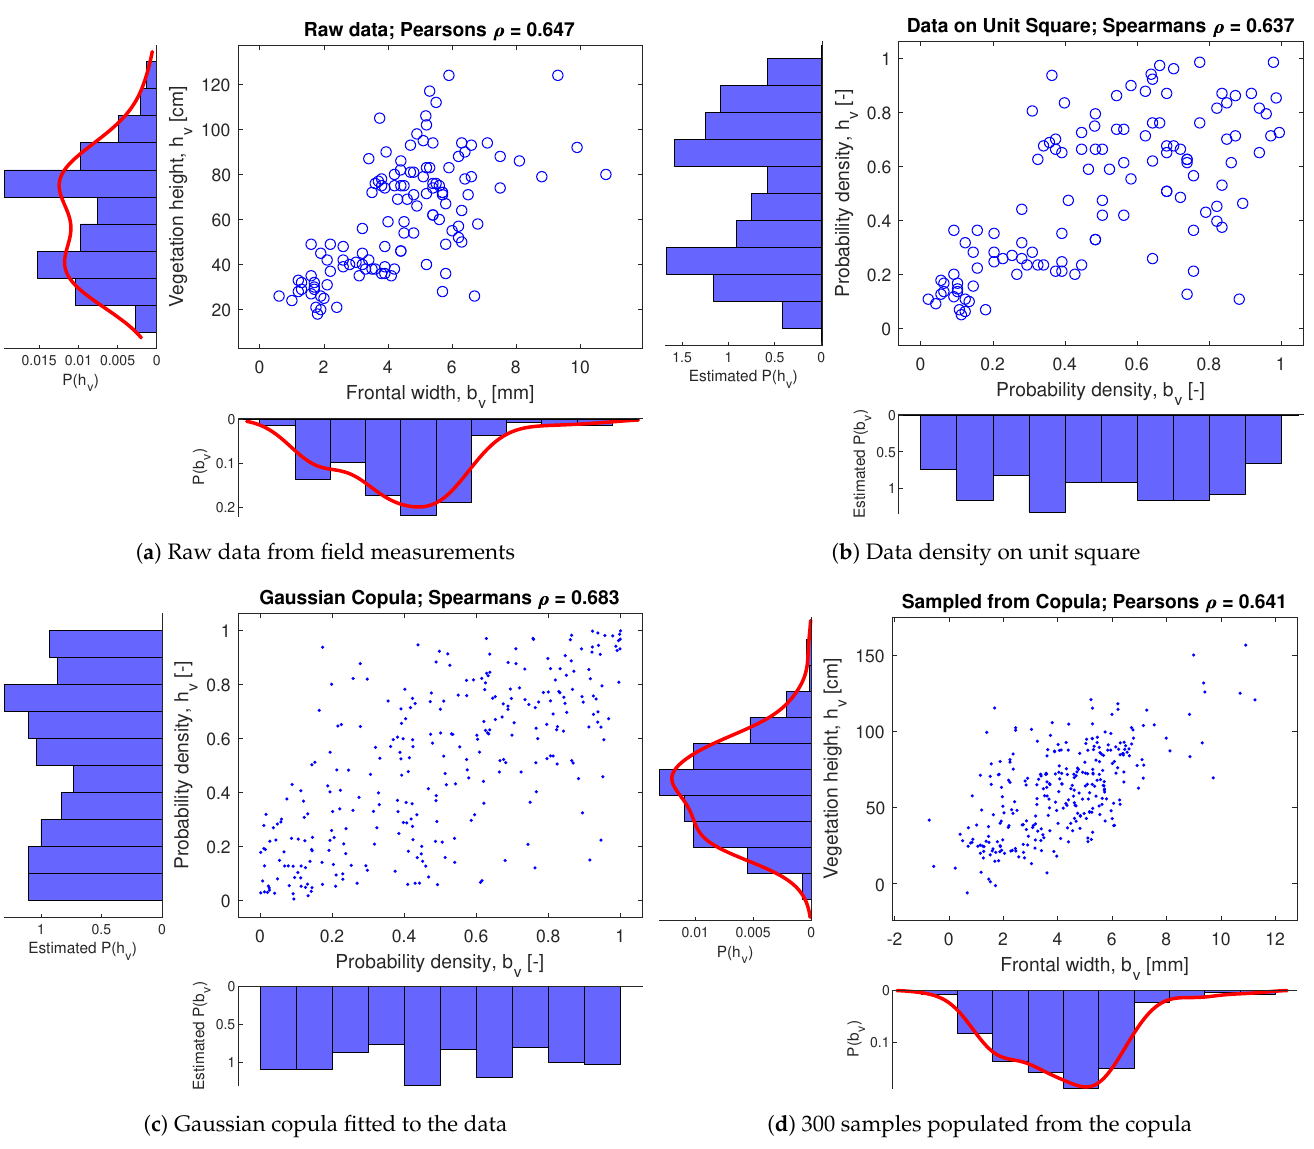
Figure 6. Copula and correlations from field data for vegetation height ( h v ) and frontal width ( b v )